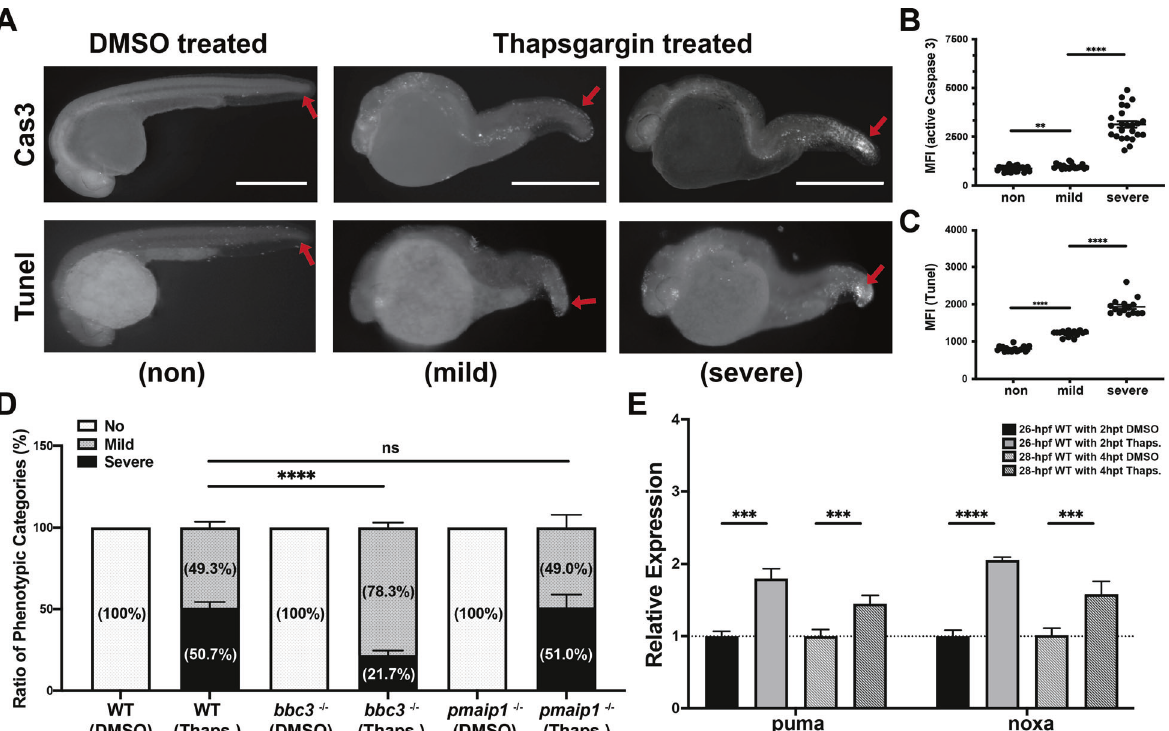
Fig. 5 Loss of puma partially rescues Thapsigargin (Thaps.)-induced apoptosis at early embryonic stage. A Anti-active Caspase-3 (The Upper Panel) and TUNEL (The Lower Panel) staining on 28 hpf (4 h post treatment) wild-type zebra fi sh embryos with DMSO alone or with DMSO plus 5 μ M Thaps. Representative fi gures showing phenotypic categories of the apoptotic severity. Arrows points out apoptotic area in tail region in WT embryos with DMSO alone or with DMSO plus 5 μ M Thaps for 4 h. Scale bar, 1000 μ M. B Quanti fi cation of the fl uorescence intensity of tail region of DMSO-treated and Thaps. treated embryos in mild and severe categories with anti-active Caspase-3 staining. Each dot represents mean fl uorescence intensity (MFI) of the tail region of individual embryos from three independent experiments. Bars represent mean ± SEM. ** p < 0.01.**** p < 0.0001. C Quanti fi cation of the fl uorescence intensity of tail region of DMSO-treated and Thaps. treated embryos in mild and severe categories for TUNEL staining. Each dot represents mean fl uorescence intensity (MFI) of the tail region of individual embryos from two independent experiments. Bars represent mean ± SEM. **** p < 0.0001. D Loss of puma (not noxa) partially rescued Thaps. induced apoptosis at 24 hpf. Ratio of phenotypic categories in wild type, bbc3 − / − and pmaip1 − / − zebra fi sh embryos. n = 7 (wild type and bbc3 − / − ) and n = 4 (pmaip1 − / − ) from pooled embryos per sample. The total number of Thaps. treated embryos: wild type > 1000, bbc3 − / − > 900 and pmaip1 − / − > 550. Bars represent mean ± SEM. **** p < 0.0001. E qRT-PCR analysis of puma and noxa after DMSO or 5 μ M Thapsigargin treatment in 24 hpf zebra fi sh embryos across time (2hpt and 4hpt). Expression levels were normalized to GAPDH. n = 5 (26- hpf WT with or w/o 2 h post Thaps. treatment) and n = 9 (28-hpf WT with or w/o 4 h post Thaps. treatment) from ~30 pooled embryos per sample. Bars represent mean ± SEM. *** p < 0.001; **** p <